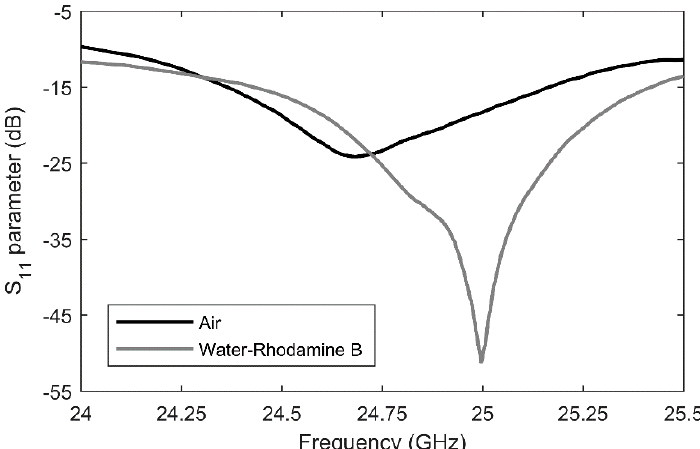
Figure 8. The S 11 parameter at the coaxial connector reference plane on the feeding PCB loaded with the microwave-microfluidic chip in which the IDC heater is loaded with air and the liquid mixture at 23.5 °C.